Question: Briefly state, in one sentence, what is plotted here.
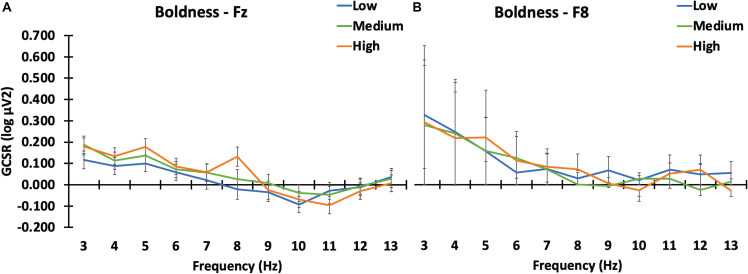
Answer: EEG power of boldness groups on GCSR at Fz and F8 . Note : The Y axis represents the EEG power (log µV 2 ) for the GIS (GCSR) measure. Boldness groups are: low (blue); medium (green; and high (orange). The X-axis is the frequency (Hz). A . Findings at Fz. B . findings at F8. Error bars represent standard error.